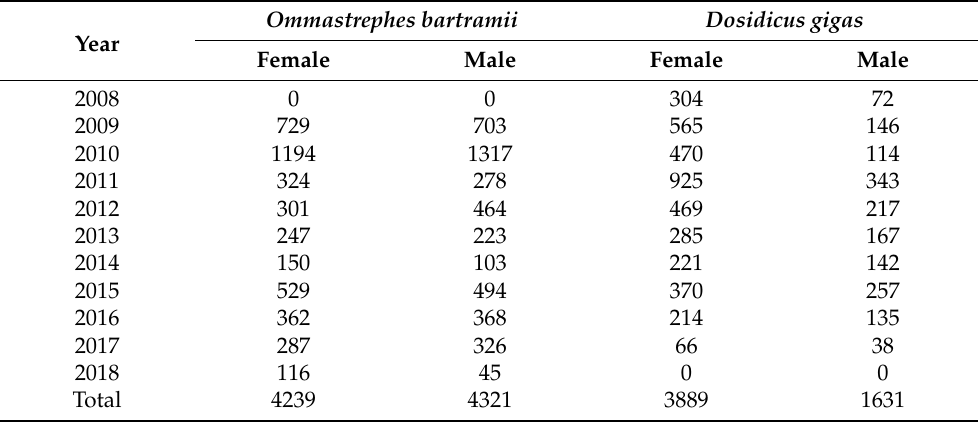
Table 1. Sample size (total number) of Ommastrephes bartramii and Dosidicus gigas among years and sexes. Ommastrephes